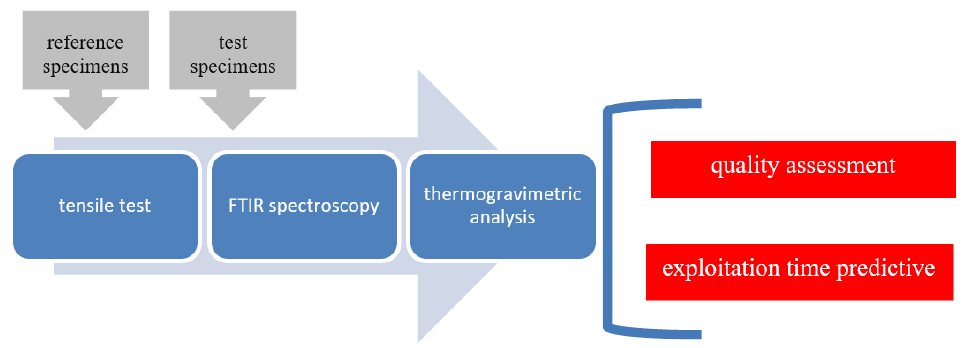
Figure 6. Research scheme.